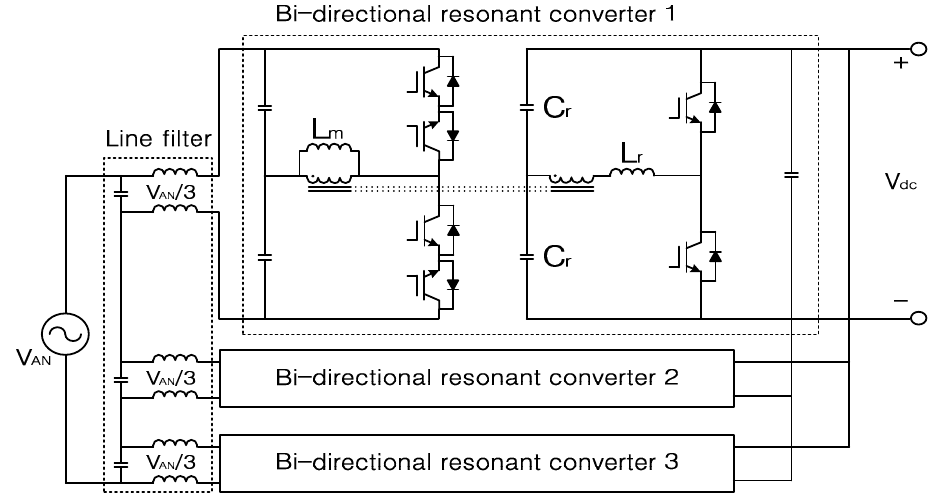
Figure 2. Circuit diagram of bidirectional high ‐ frequency AC–DC rectifier.